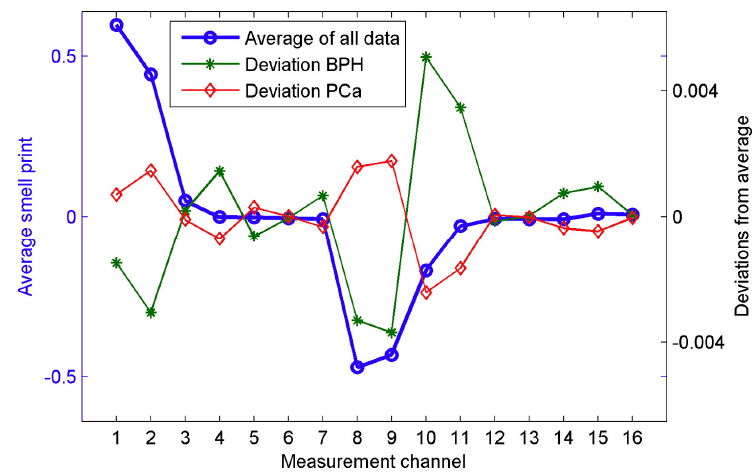
Figure 9. Total average of all data represents typical smell print of urine. Characteristics of average smell prints of benign protastic hyperplasia (BPH) and principal component analyses (PCA) groups are depicted by deviation from total average. Used with permission from [33].